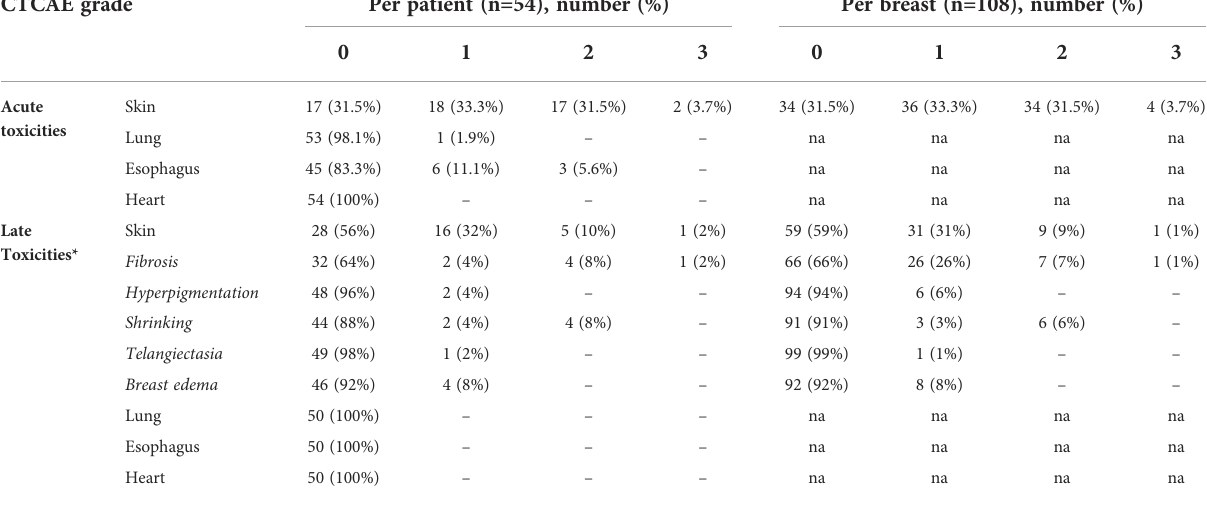
TABLE 3 Acute and late radiation-related